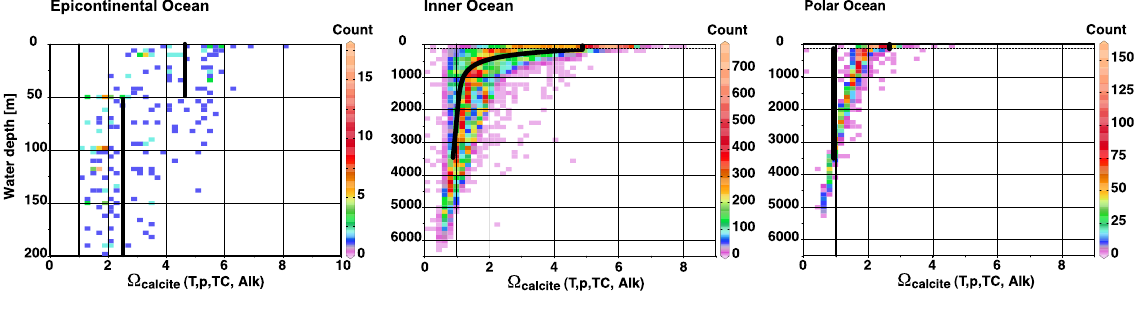
Fig. 9. Simulated steady state depth profiles of saturation state ( (cid:127) calcite ) in the epicontinental, inner and polar ocean (black line). Simulation results are compared to calcite saturation calculated based on WOCE Hydrographic Program (*hy1.csv files from WHPO web-site as of 27 May 2002) observations using the in-situ temperature, pressure, T C and T A (Fig. 7). The colour code indicates the number of times a concentration is reported for a given water depth.